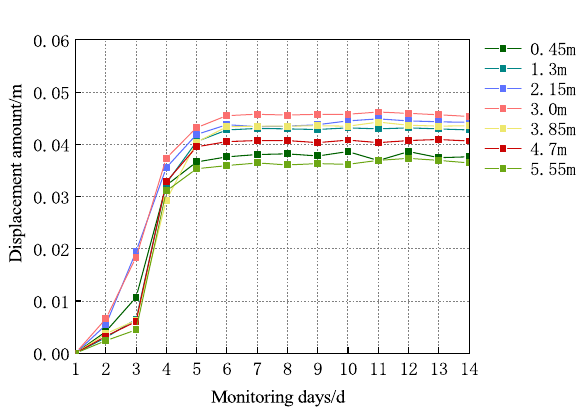
Figure 11. Monitoring diagram of surrounding rock displacement of roadway roof.